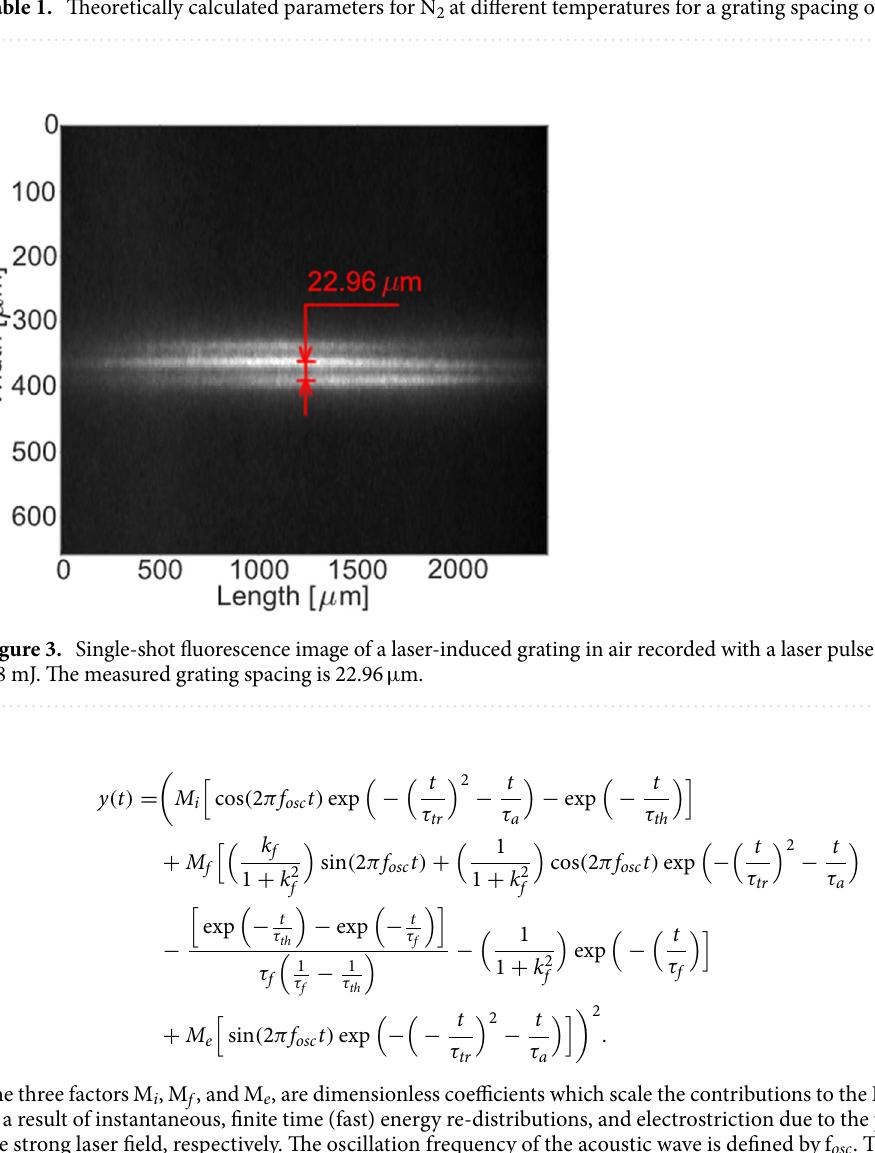
Table 1. Theoretically calculated parameters for N 2 at different temperatures for a grating spacing of 23.56 µ m.